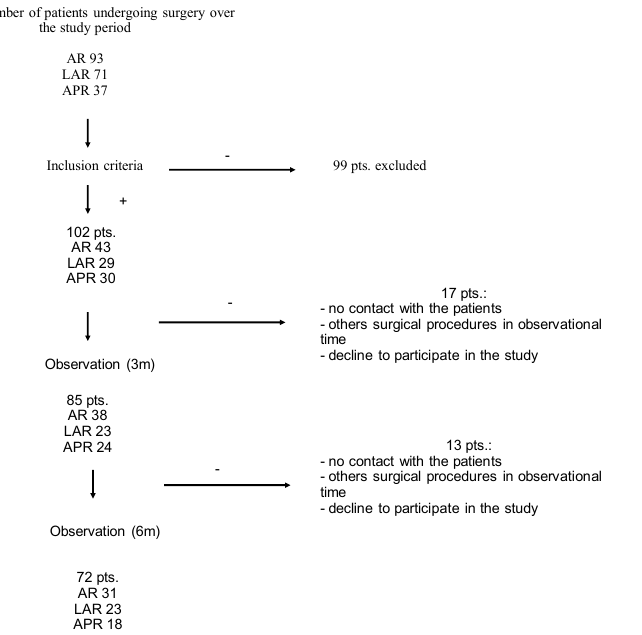
Figure 1. Study flow chart.APR: Abdominoperineal resection; LAR: Laparoscopic anterior resection; AR: Anterior resection.